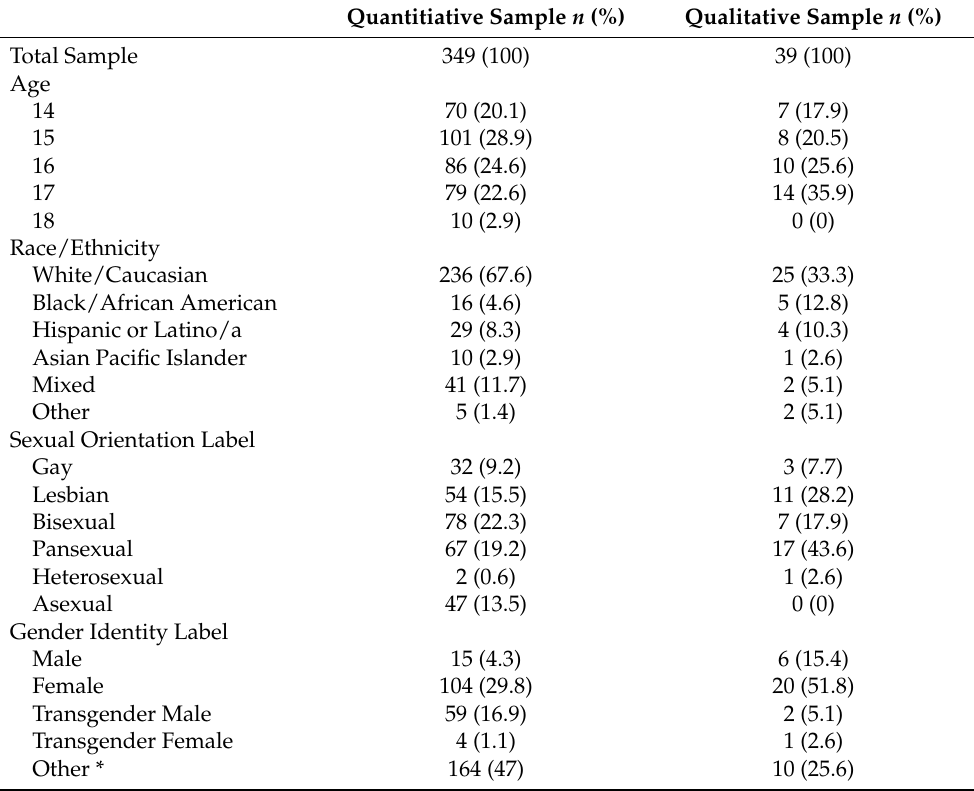
Table 1. Demographics of participants from the quantitative and qualitative